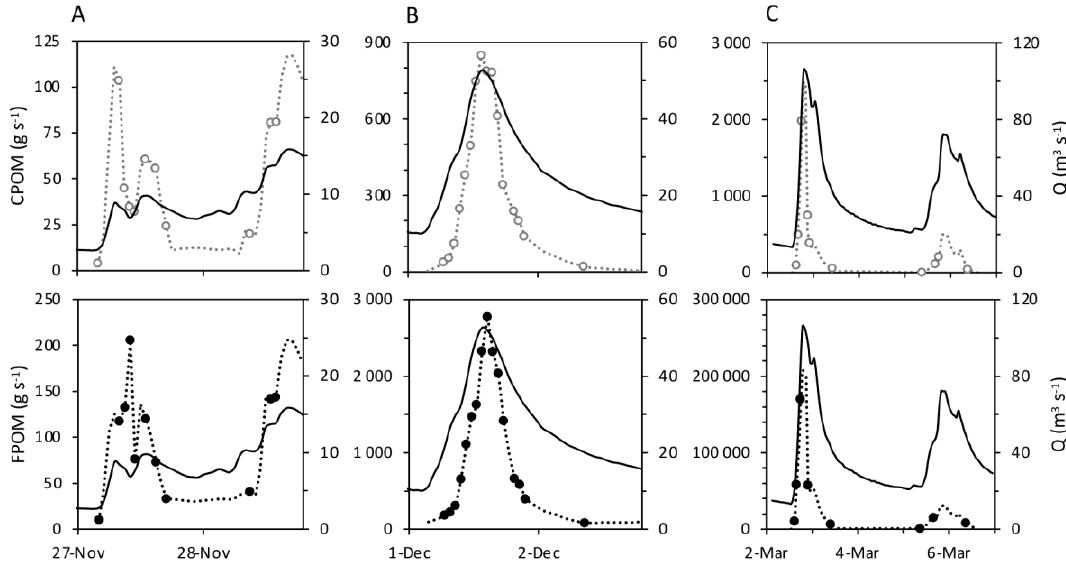
Figure 5. Time variation of discharge (m 3 s − 1 ) and transport load (g s − 1 ) of CPOM (gray open dots) and FPOM (black dots) during three selected high flow events. ( A ) 1–2 December 2019; ( B ) 27–29 November 2019; ( C ) 2–7 March 2020. Dots indicate measurements, and dotted lines indicate interpolated values.